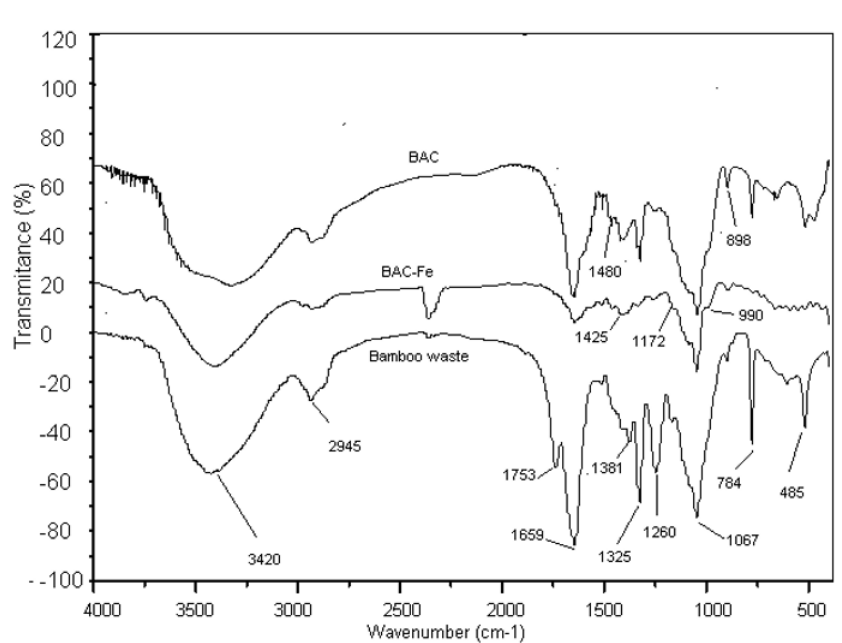
Figure 4. FT-IR spectra of synthesised activated